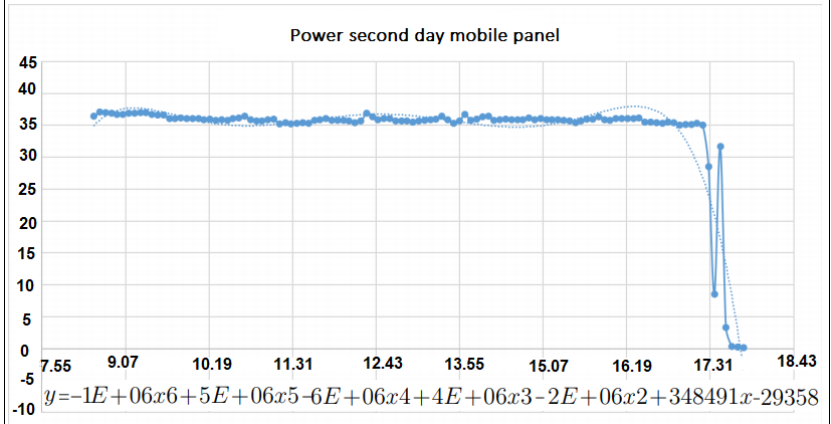
Figure 19: Graph of power generated second day with mobile panel. Source: Authors, (2022).